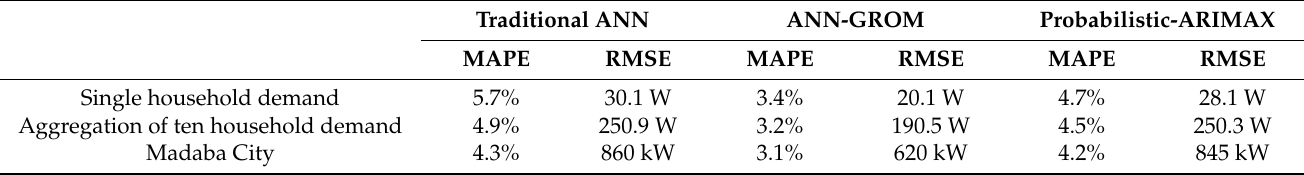
Table 9. Overall performance of the proposed forecast models for demand disaggregation.